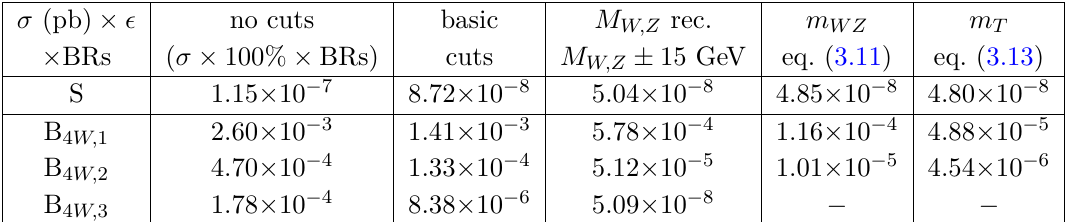
Table 4 . The rates of σ (pb) × (cid:15) × BRs for the signal H ±± H ∓ → WWWZ → µ µ ν µ ν µ JJ and SM backgrounds, before and after selection cuts. We choose m √ collider with s = 30 TeV